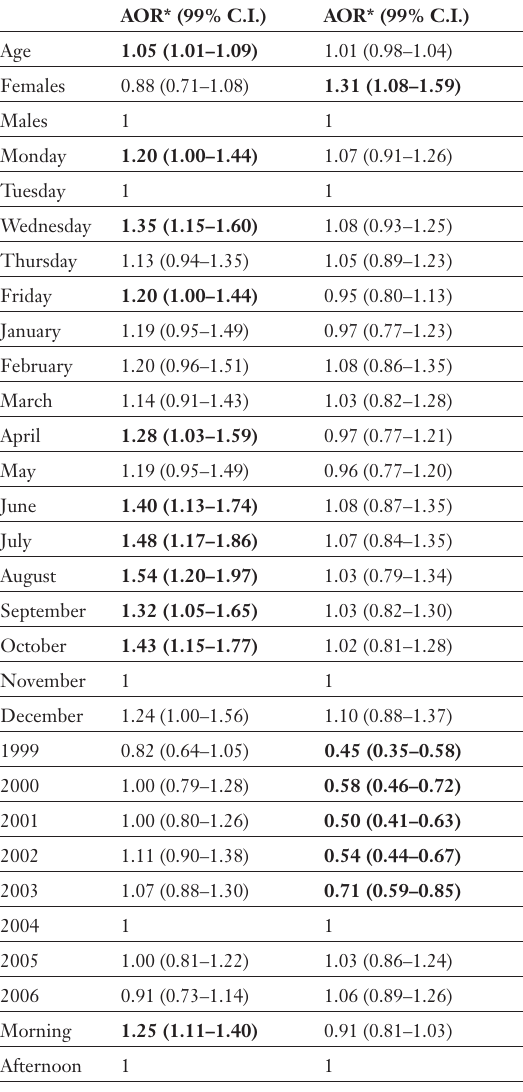
Table 2 logistic regressions (n = 32541) for missed and cancelled appointments (refer- ence category: attended appoint- ment) with age, sex, weekday, month, year and period of day as